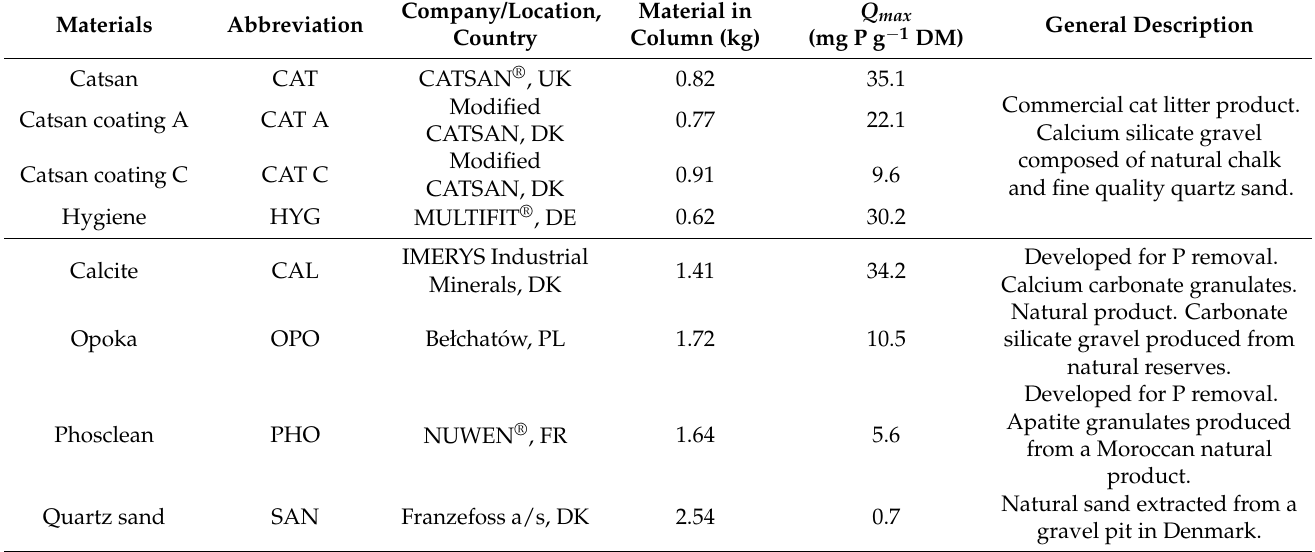
Table 1. Material information and their maximum P adsorption capacities ( Q max ). The materials include six non-modified materials and two coated materials, CAT A and CAT C, with CAT A having a thin layer Sol–Gel coating and CAT C having a denser coating layer. Material in column shows the average amount of material installed in the columns ( n = 2, except CAL, n = 1). Q max were determined by fitting a non-linear Langmuir model in Jensen